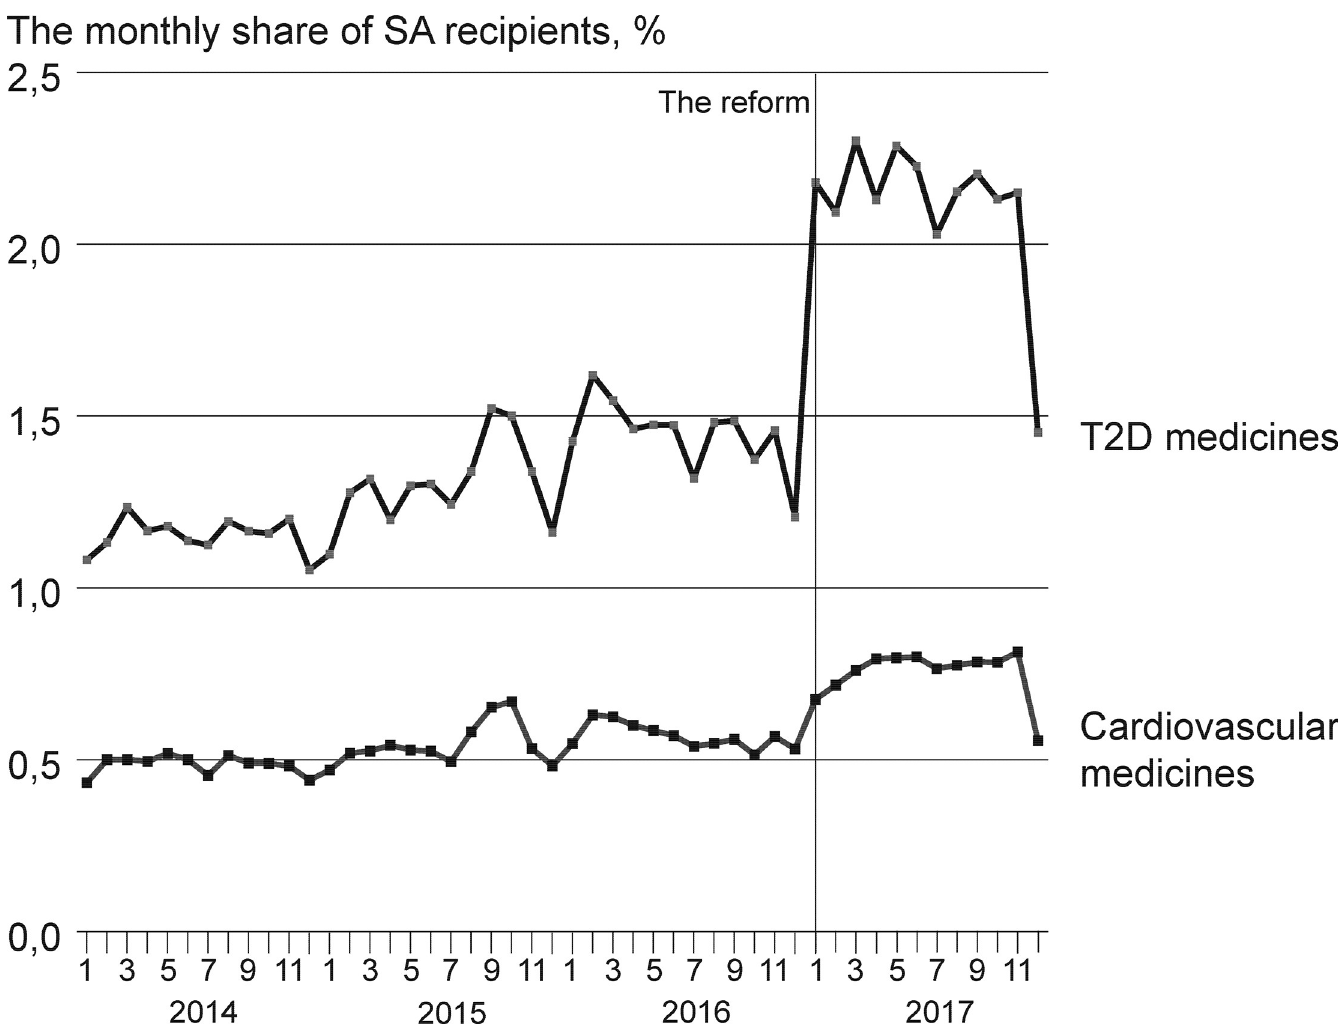
Fig 1. Time trends for the monthly share of social assistance (SA) recipients among patients purchasing type 2 diabetes (T2D medicines) medicines and medicines for chronic hypertension or hyperlipidemia (cardiovascular medicines) medicines in